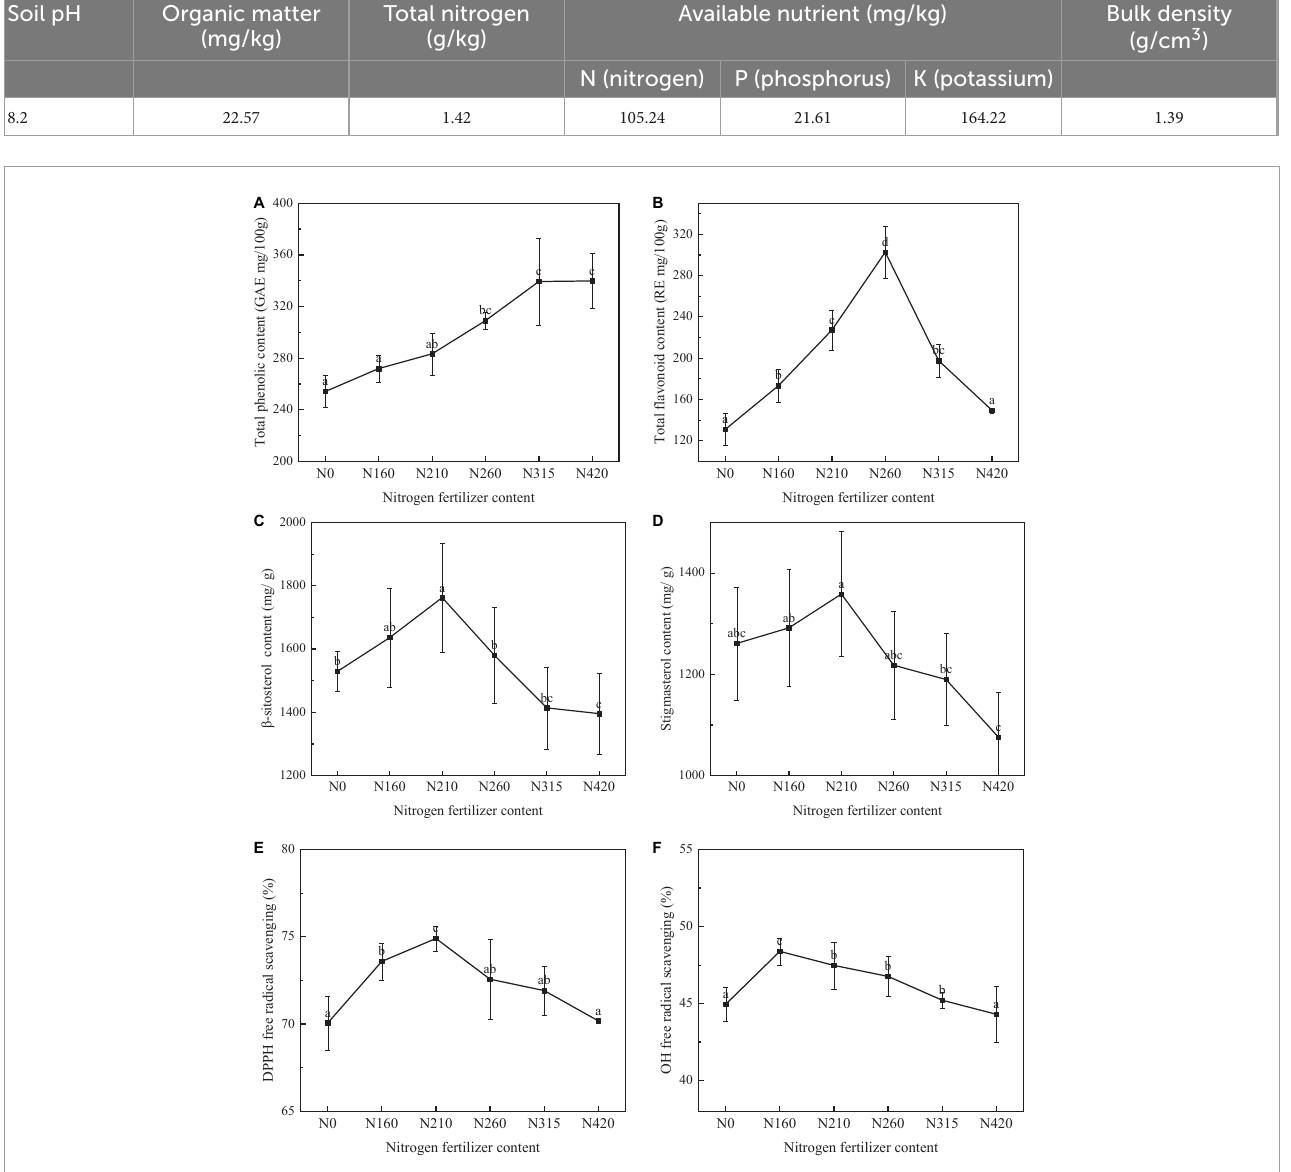
FIGURE1 Effect of different amounts of nitrogen fertilization on the total phenolic (A) , flavonoids (B) , β -sitosterol (C) , stigmasterol (D) , DPPH (E) , and OH (F) content of brown rice (lowercase represent differences between groups, P < 0.05).